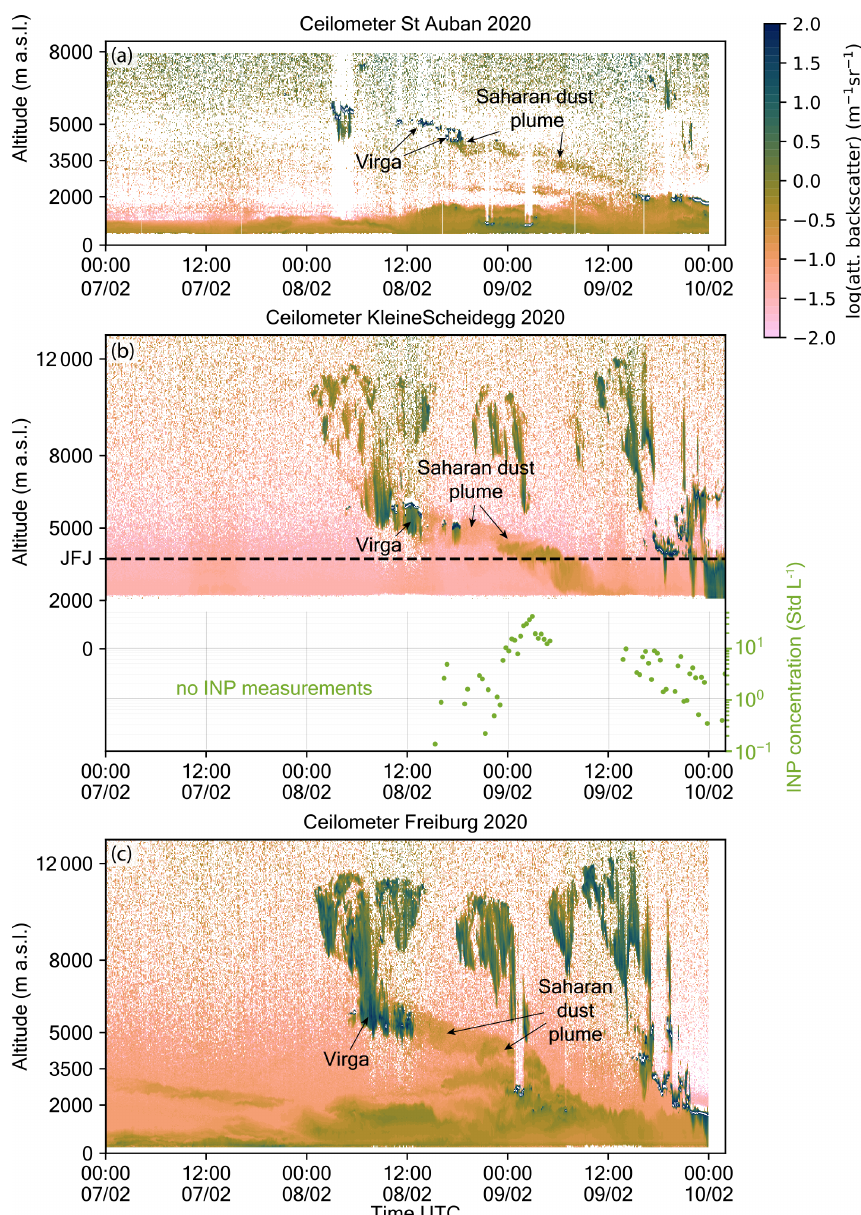
Figure 11. Vertical profiles of the attenuated backscatter from the ceilometer at Saint-Auban (StA, a ), Kleine Scheidegg (KSE) with INP concentrations at JFJ ( b ), and Freiburg (FRE, c ), with the dust plume and connecting virga visible between 8 February, 03:00UTC, and 9 February,